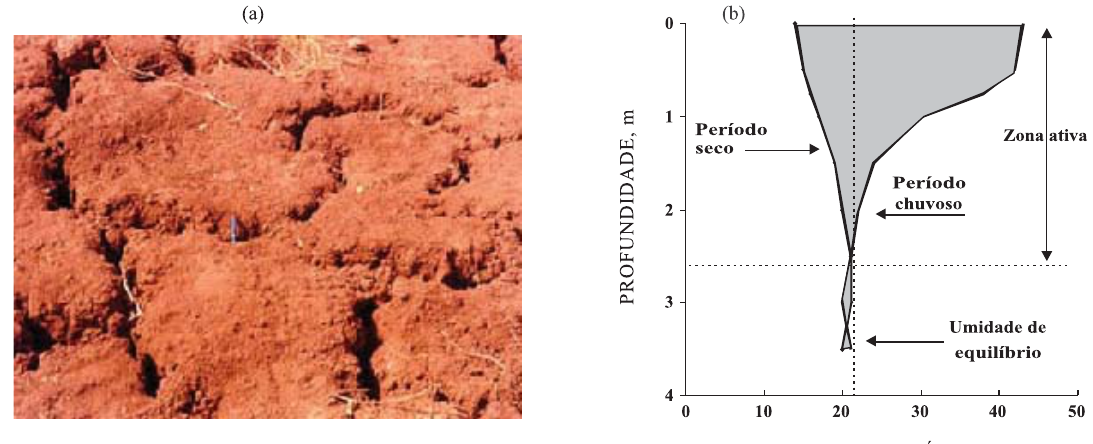
Figura 3. Vertissolo de Petrolândia-PE: (a) fissuras e microrrelevos em período seco; (b) variação da umidade com a profundidade, do período seco ao